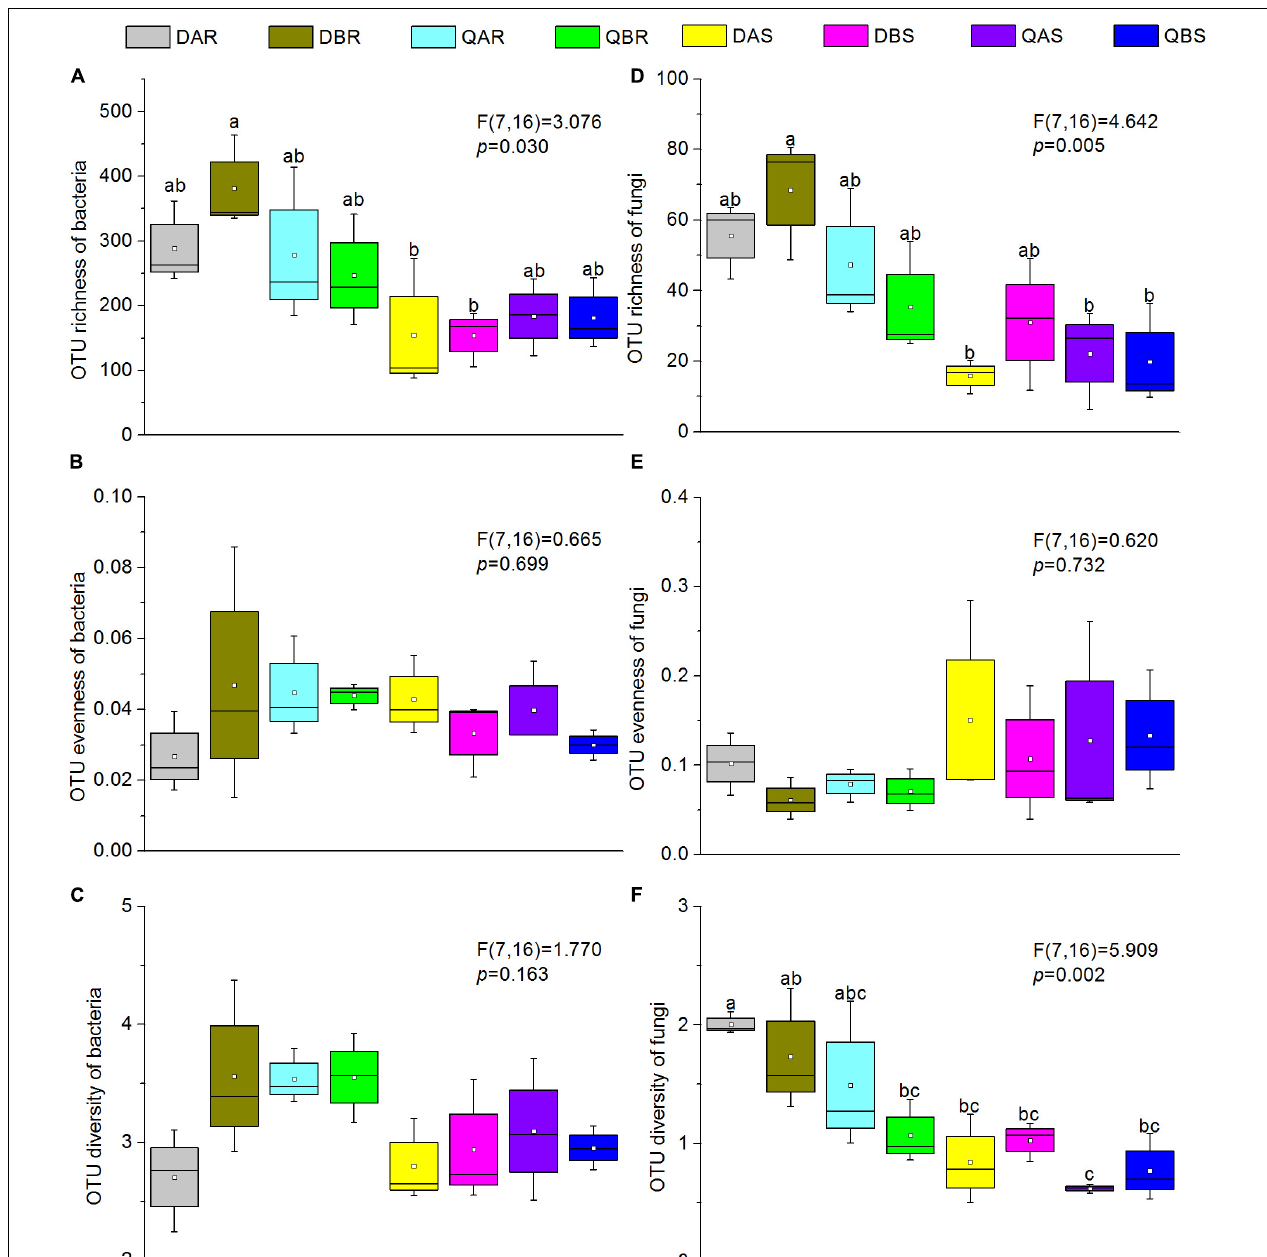
FIGURE 1 | Alpha diversity estimates of bacterial and fungal communities in transgenic and non-transgenic poplars. (A) Operational taxonomic unit (OTU) richness of bacteria. (B) OTU evenness of bacteria. (C) OTU diversity of bacteria. (D) OTU richness of fungi. (E) OTU evenness of fungi. (F) OTU diversity of fungi. The richness, evenness, and diversity of bacterial and fungal communities are displayed with the bootstrap, Simpson evenness, and Shannon indices, respectively. Box plots display the first (25%) and third (75%) quartiles, the median, mean, and the maximum and minimum observed values within each data set. Alpha diversity estimates represent three biological replicates for each set. Data were analyzed using one-way analysis of variance (ANOVA) and Tukey post hoc comparisons. The overall plant compartment effects (F(DFn, DFd) and p -value) are displayed at the top of each graph. Significant differences ( p < 0.05) across plant compartments are indicated using lowercase